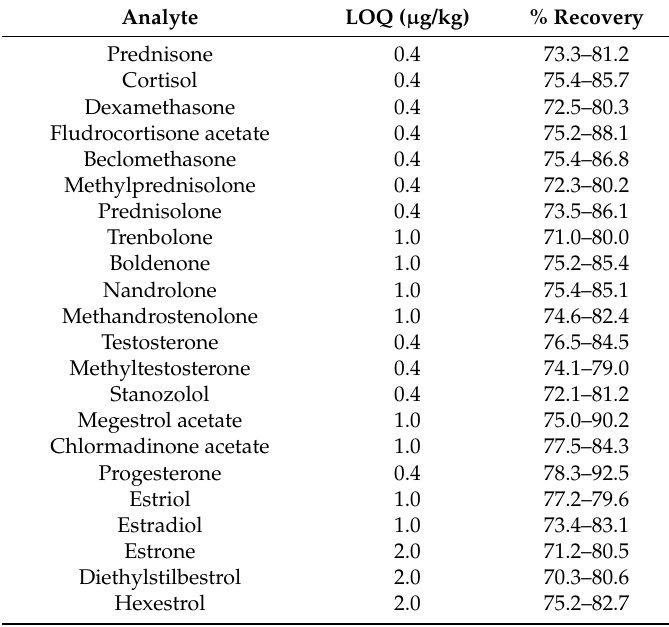
Table 2. The recovery and limit of quantification (LOQ) of the